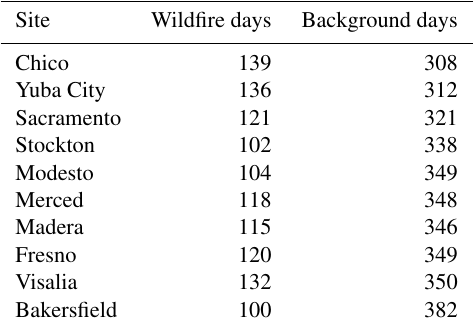
Table C1. Constants in Eq. (1) for NO 2 correction (Steinbacher et al., 2007). The result is from the multiple linear regression model at the Taenikon site.